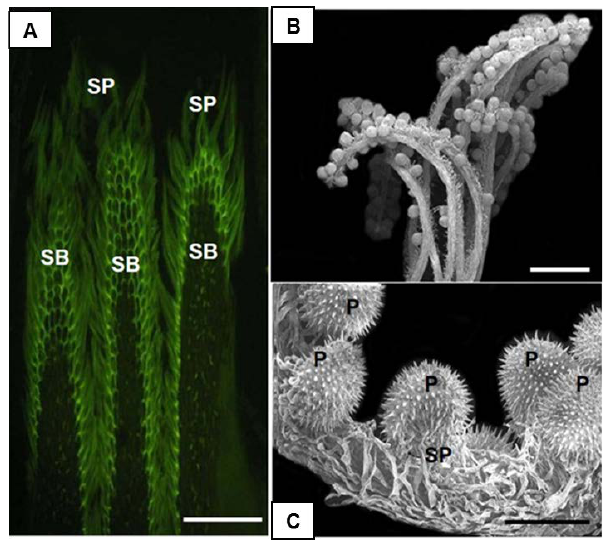
Fig. 9. Stage 12: Stigma receptivity. A. Three of the ten branched mature stigma. B. SEM analysis of ten branched stigma. C. SEM analysis of the stigmatic papillae with pollen grains. P: Pollen, SB: Stigmatic branches, SP: Stigmatic papillae. Bar: 5 µm (A), 500 µm (B), 100 µm